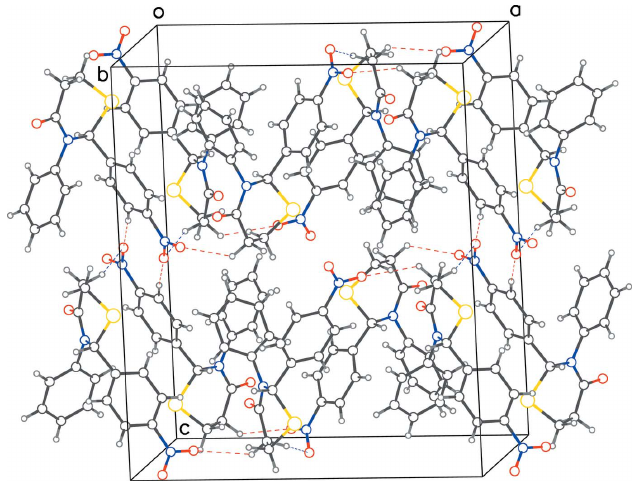
Figure 3 Packing diagram for 1 , showing the layering of molecules in the ab plane. Red dotted lines show hydrogen bonds between enantiomers and blue dotted lines show interactions between molecules of same chirality.